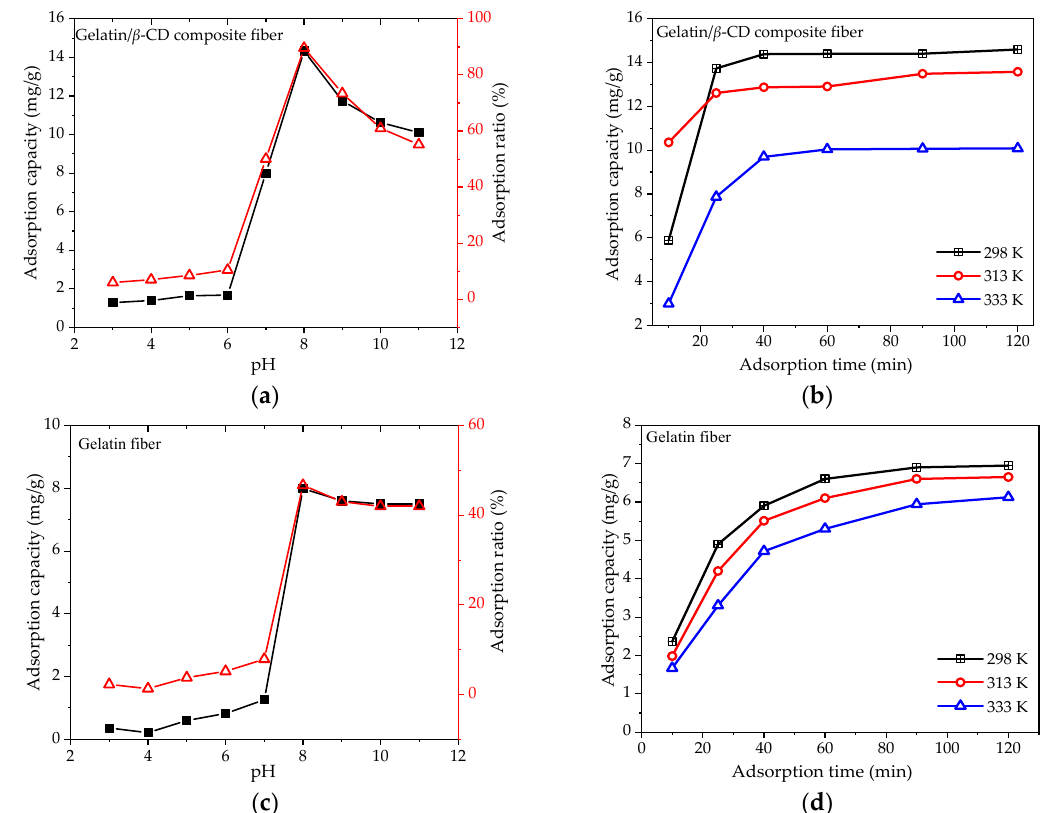
Figure 8. Effects of initial pH values ( a , c ) and temperature ( b , d ) on the adsorption property of MB.